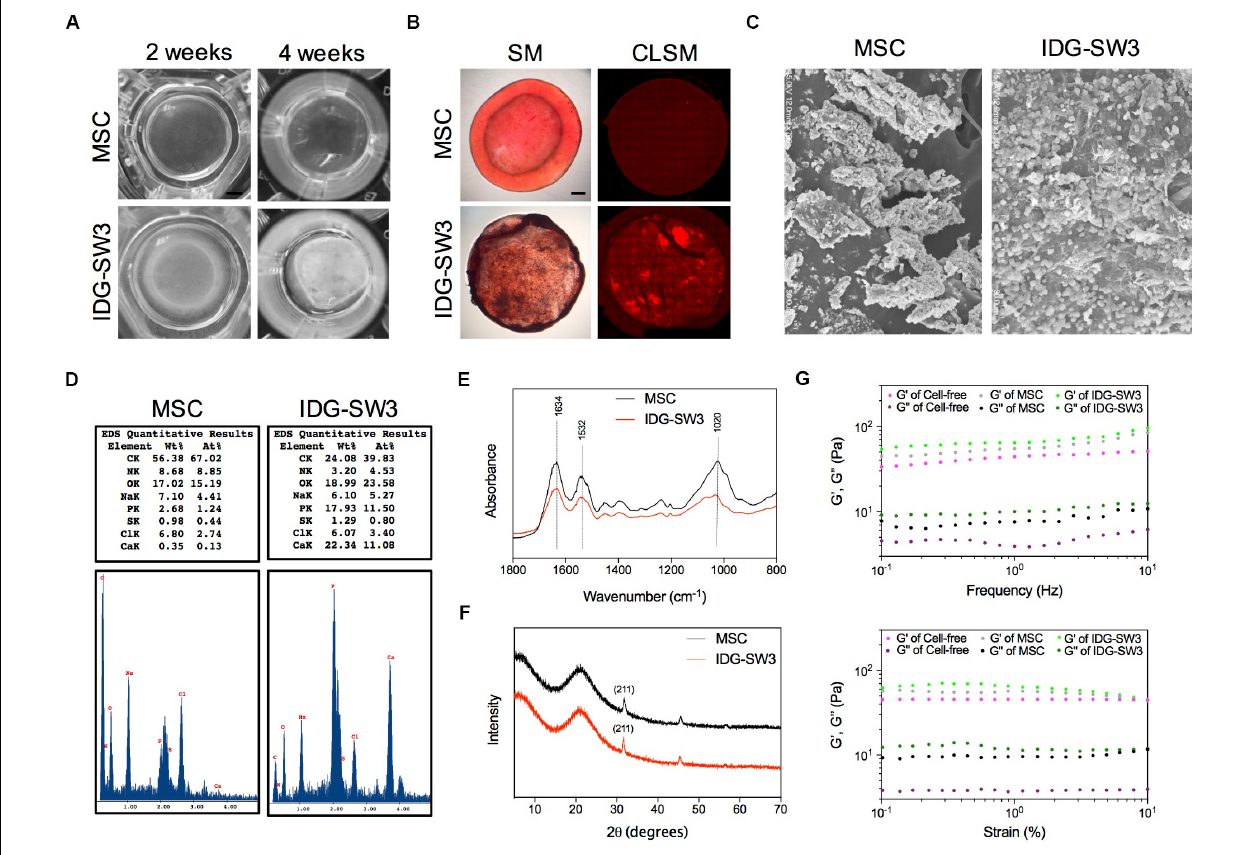
FIGURE 3 | Enhanced mineralization activity of IDG-SW3 cells compared to BMSCs. The physical and chemical properties of mineralized 3D gels containing IDG-SW3 cells and BMSCs after 4-week differentiation. (A) The outward appearance of the mineralized 3D gels. Bar, 2 mm. (B) Alizarin Red S staining of the mineralized 3D gels, visualized with a stereomicroscope (SM) or a confocal laser microscope (CLSM). Bar, 2 mm. (C) Scanning electron microscope images of the mineralized 3D gels surface. (D) Energy-dispersive X-ray analysis of the mineralized 3D gels. (E) Fourier transform infrared spectra analysis of the mineralized 3D gels. (F) X-ray diffraction analysis of the mineralized 3D gels. (G) Viscoelastic properties of the 3D gels with or without